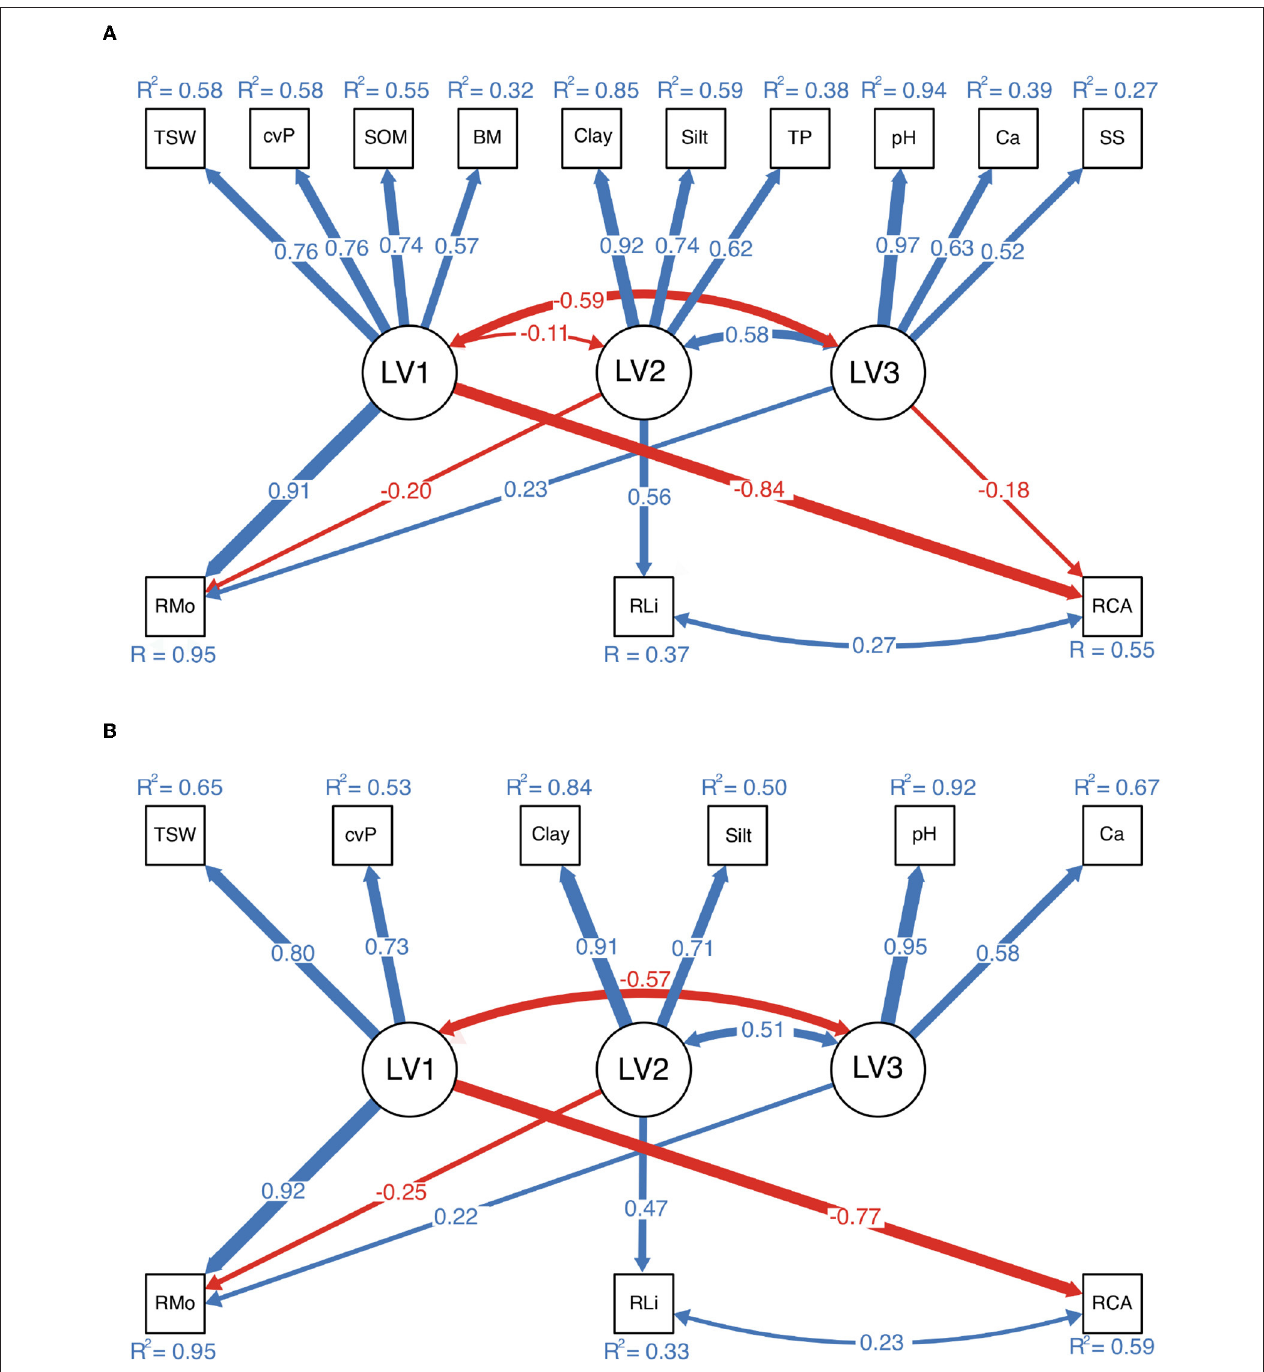
FIGURE 5 | Results of structural equation modeling. (A) Measurement model with redundant observed variables. (B) Model after the deletion of observed variables. The two models have very similar structures and standardized path coefficients (SPCs) in the structural parts. Only the paths with a significant level of 0.05 or lower are plotted. The thickness of each arrow is proportional to the SPC labeled on the corresponding path, with blue and red reflecting positive and negative values,